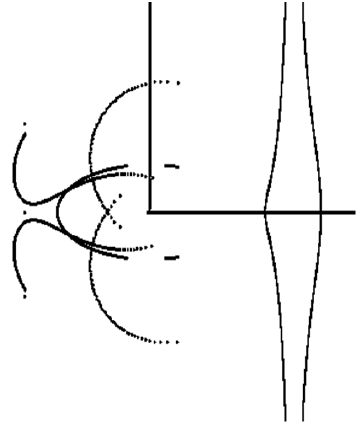
Figure 7. q = 1, KG = 60, and DK = 200.